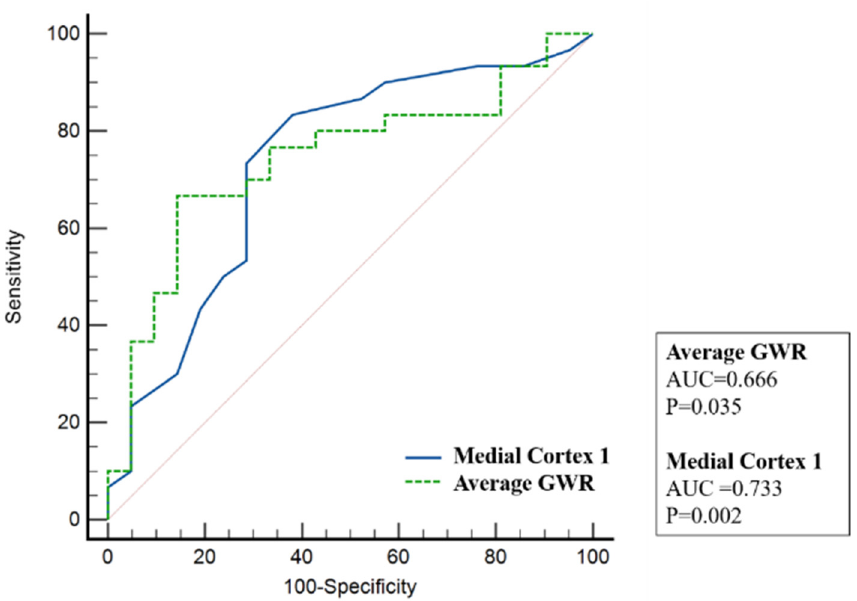
Figure 4. ROC curves to predict survival. The AUC for average GWR was 0.666 ( p = 0.035) and AUC